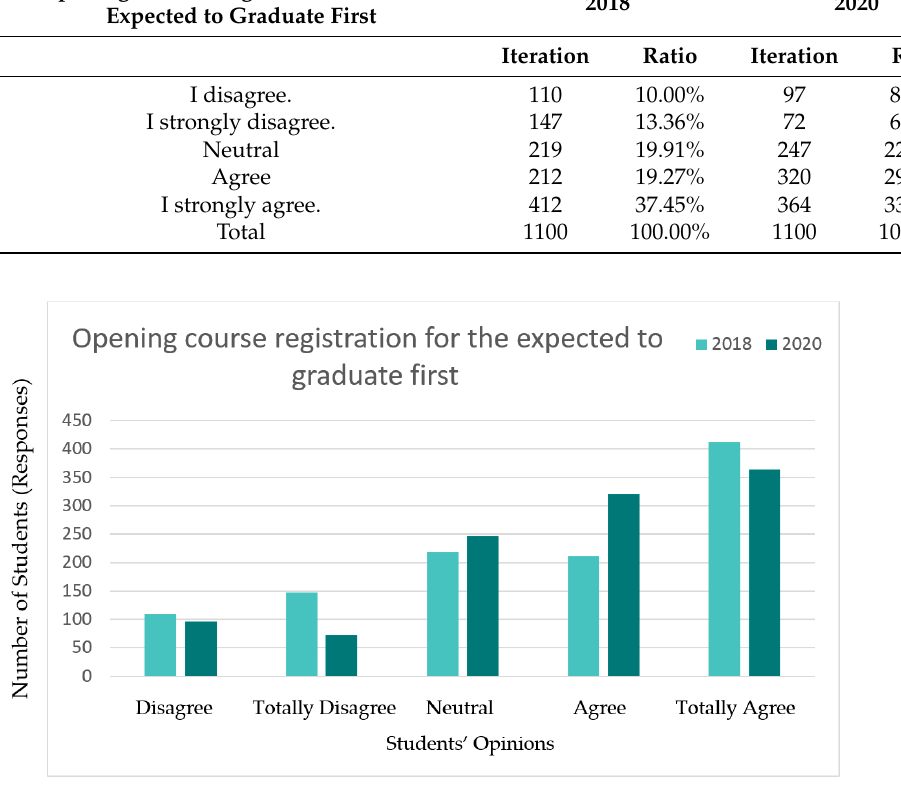
Figure 4. Distribution of student numbers according to their feedback on the progressive course registration process during 2018 and 2020 survey periods.